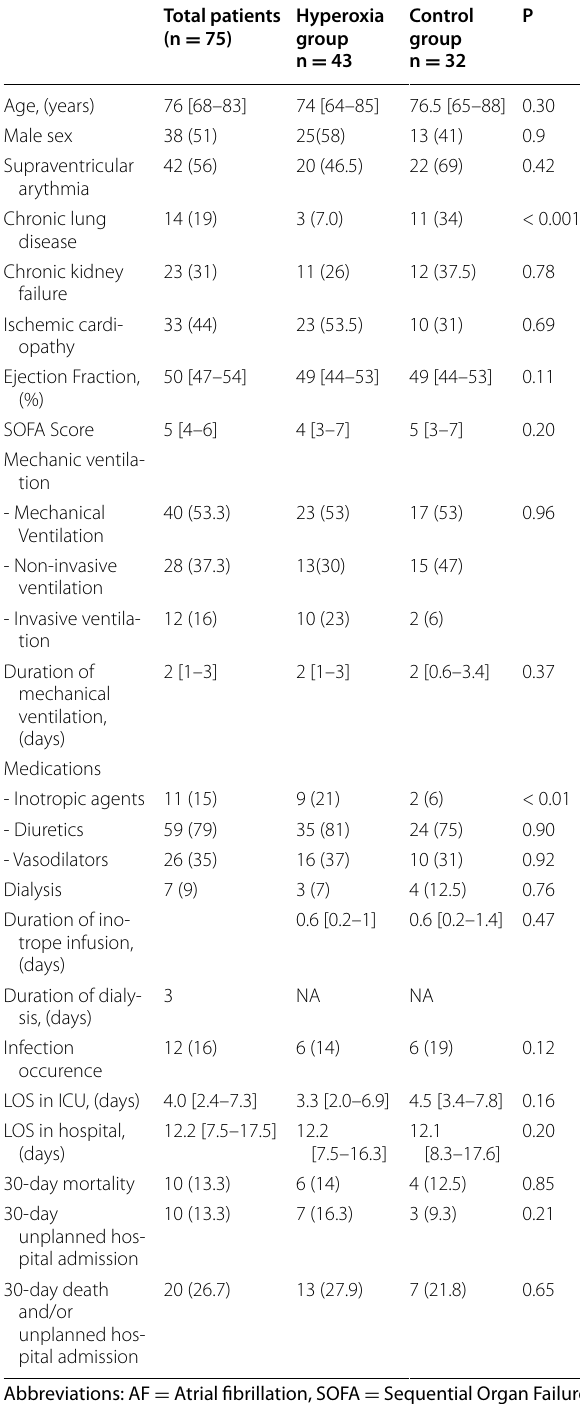
Table 1. Baselines characteristics and Outcomes Total patients